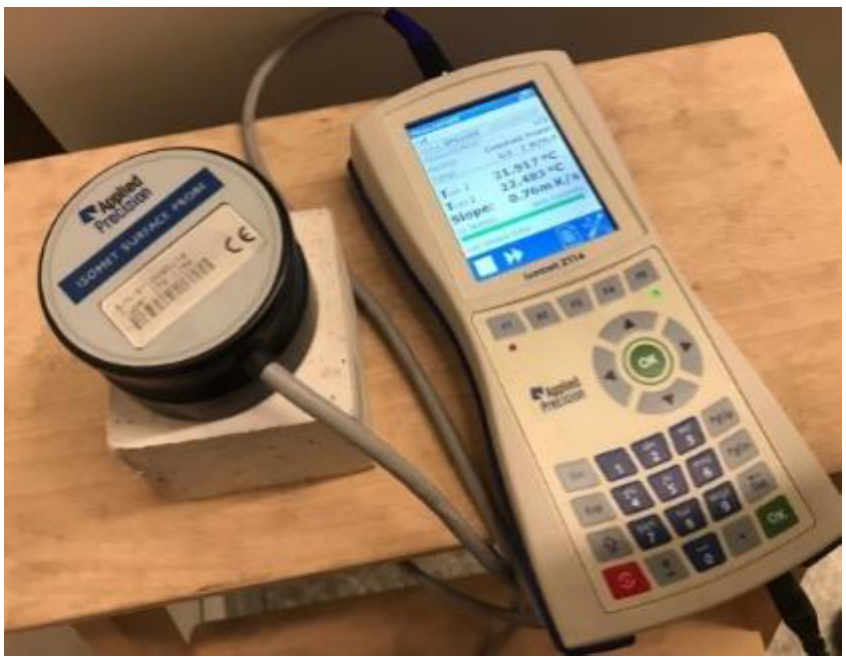
Figure 4. ISOMET 2114 device.